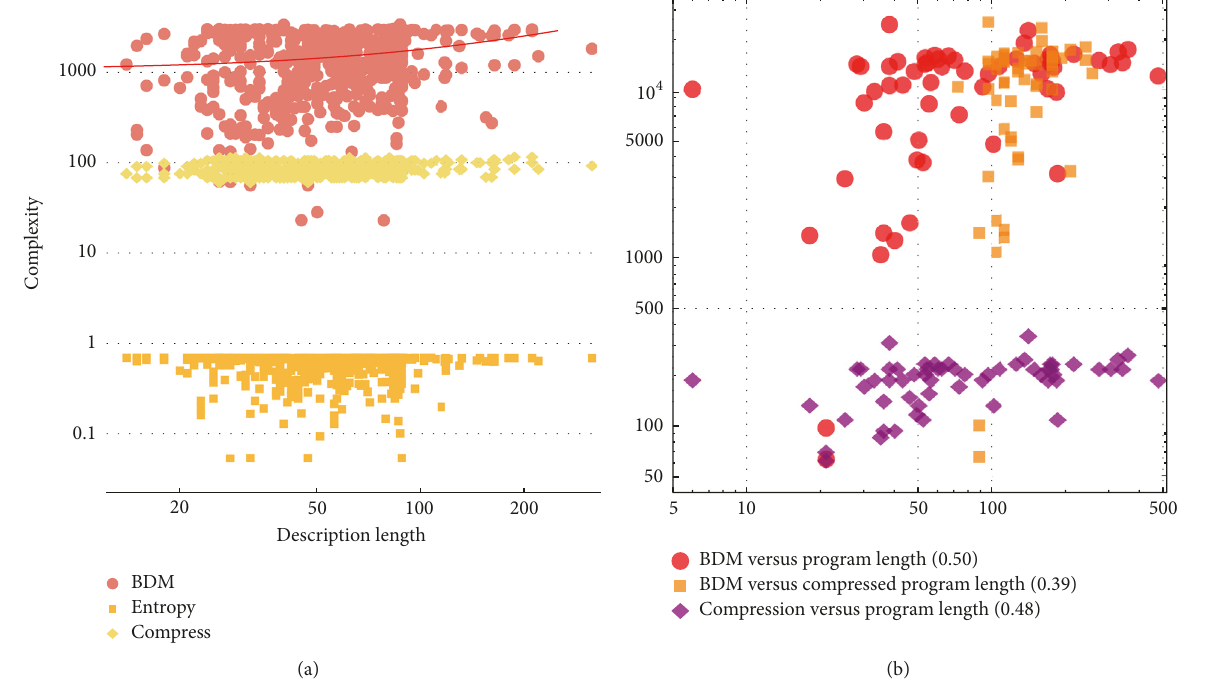
Figure 2: (a) Correlation between the estimated algorithmic complexity (log) by the AP-based measure (BDM) and the length of the text description of each sequence from the OEIS. Fitted line for highest correlation (BDM) is given by 1064.84 + 7.29𝑥 using least squares. (b) Algorithmic complexity estimation by BDM (log) and of compression on program length (in the Wolfram Language/Mathematica) as coming from the OEIS. In parenthesis, the Spearman rank correlation values for each case. Further compressing the program length using ”compress” resulted in a lower correlation value and BDM outperformed lossless